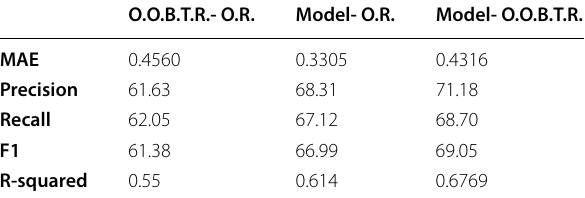
Table 6 Output comparison between final model, OR (Original Reader), and OOBTR (Out Of Box Test Reader). Model